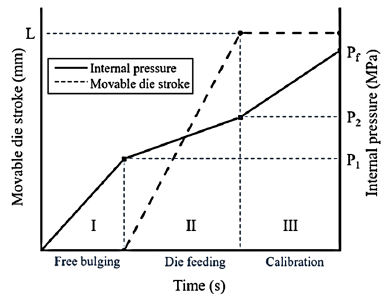
Figure 3. Designed loading path in hydroforming process with movable dies.